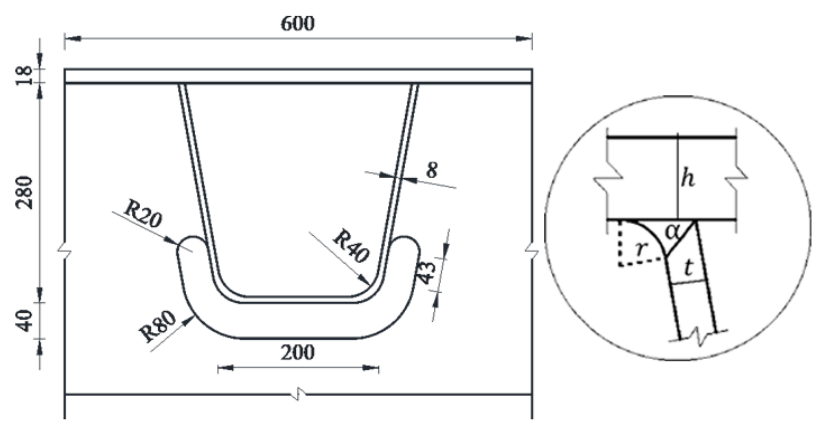
Figure 17. The diagram of the geometric parameters of the components in the OSBD (Unit mm).